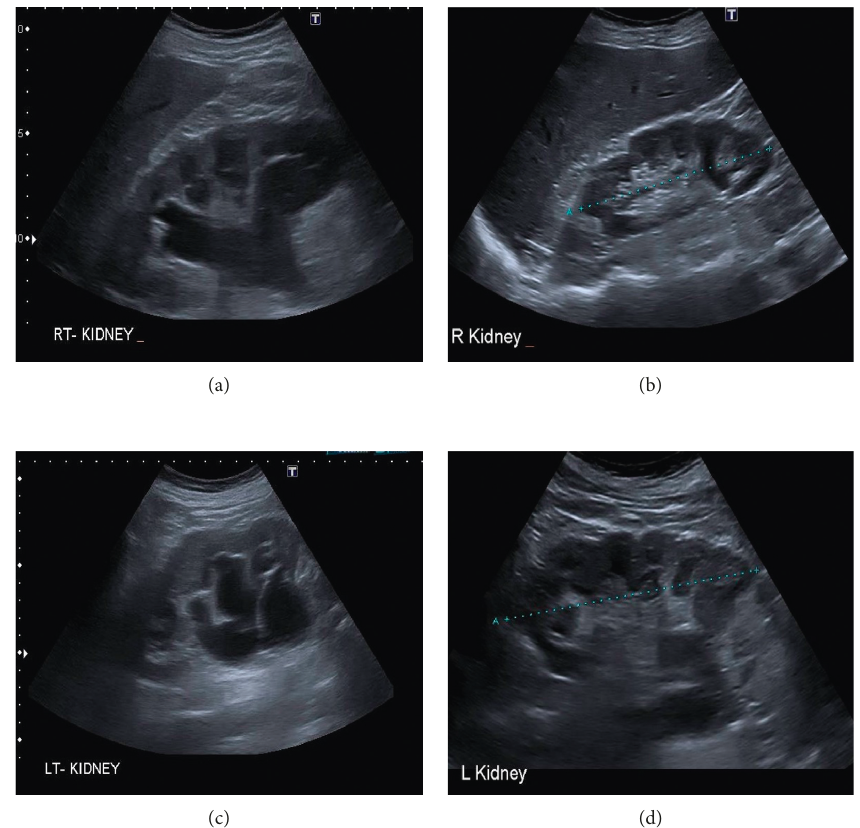
Figure 3: Preoperative ultrasound scan of the right kidney showing hydronephrosis (a) and resolution postoperatively (b). Hydronephrosis of left kidney (c) and postoperative resolution (d). Cortical cysts are